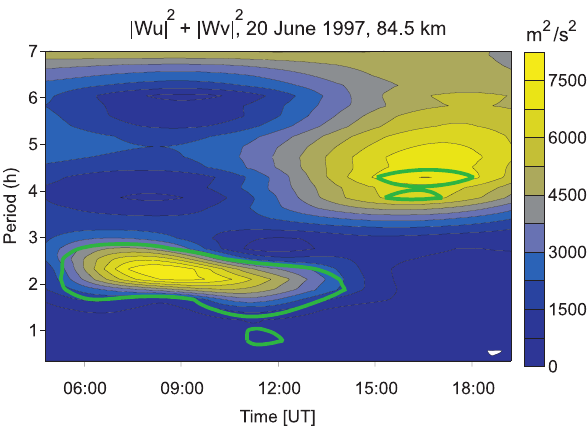
Fig. 10. Results of the Wavelet transform of horizontal winds from ALOMAR SOUSY radar measurements at an altitude of 84.5km. The bold green line outlines the region with 95% significance